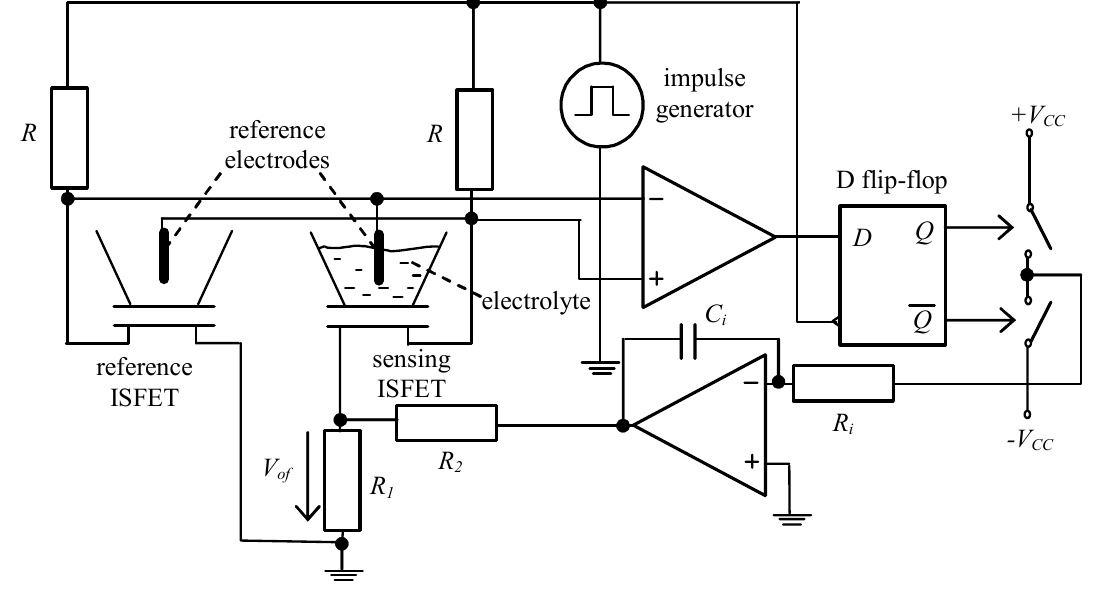
Figure 4. Measurement